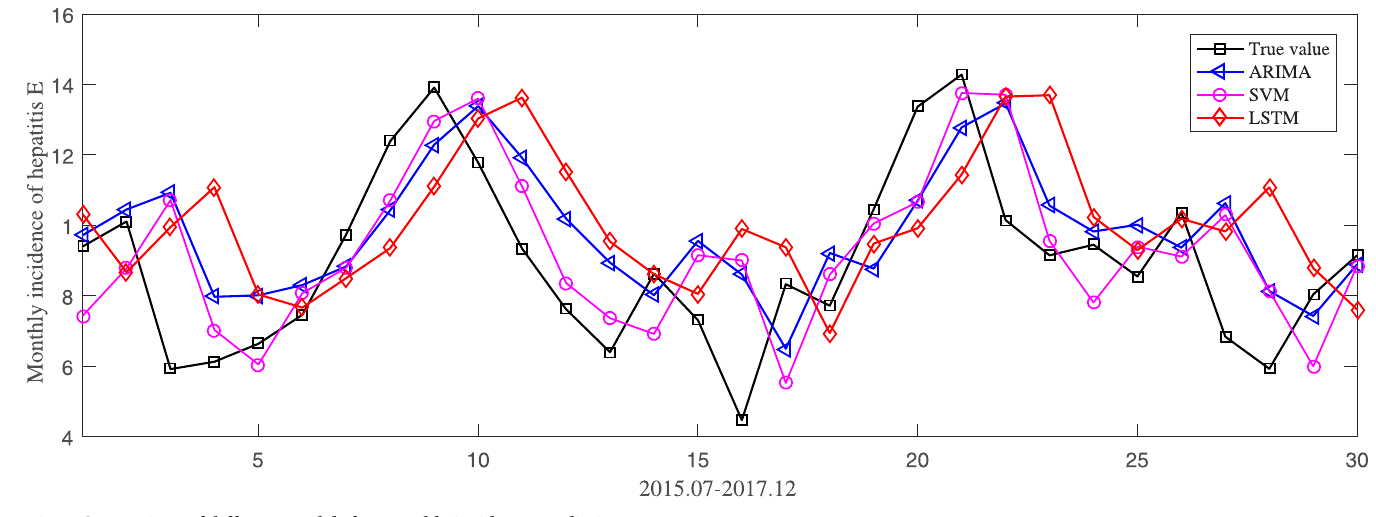
Fig 7. Comparison of different models for monthly incidence prediction.